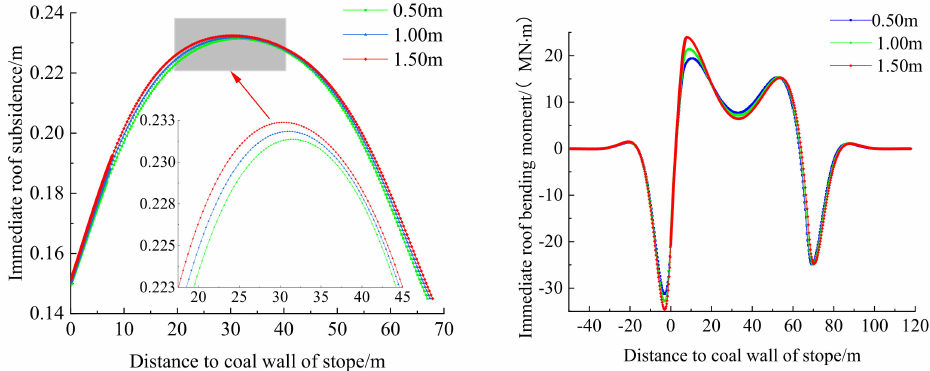
Figure 5. Relationship among the unsupported-roof distances, roof subsidence, and bending moments. (5)